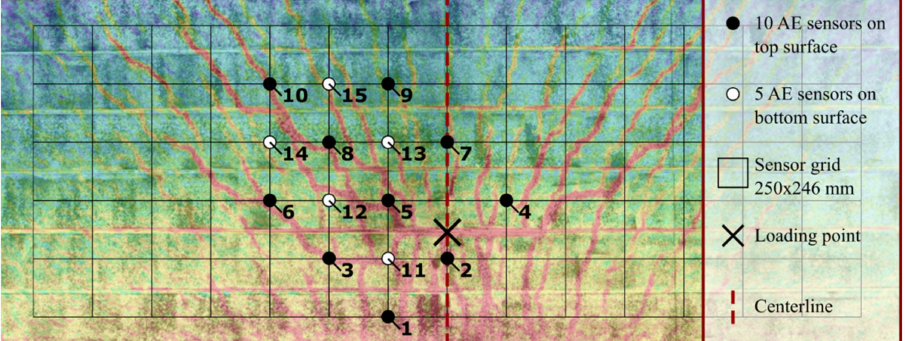
Figure 7. AE sensor plan based on the crack pattern of OT test